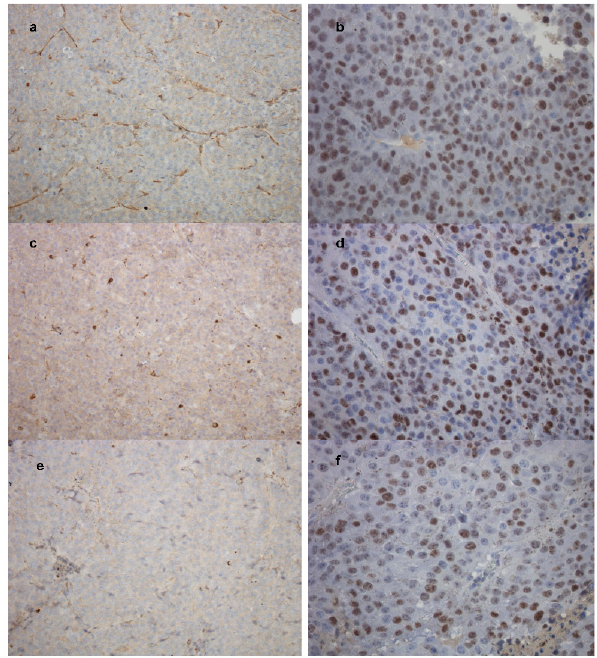
Figure 11. Immunohistochemical staining of CD31 (200×) and Ki-67 (400×) in tumor sections. ( a , b ) CD31 and Ki-67 in control group; ( c , d ) CD31 and Ki-67 in free TMZ group; ( e , f ) CD31 and Ki-67 in SLN-TMZ group.